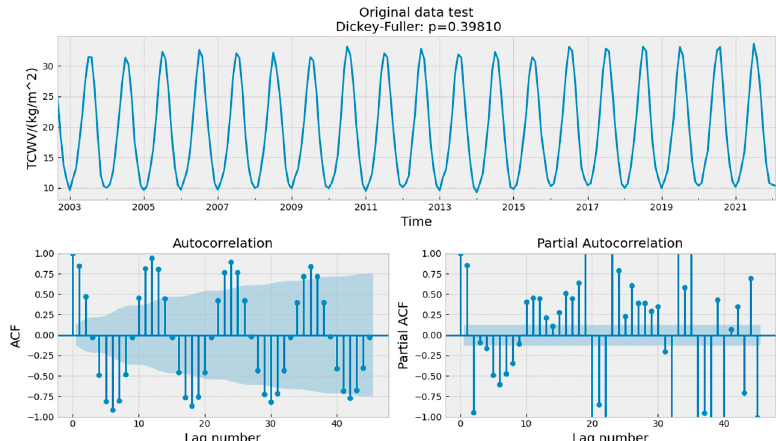
Figure 7. Time series, autocorrelation and partial autocorrelation of